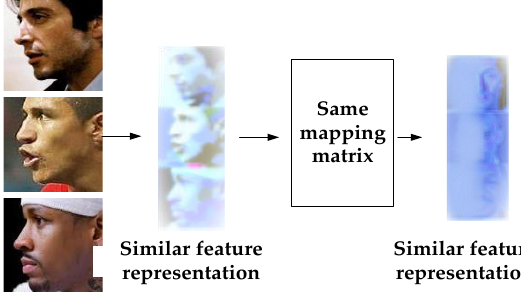
Figure 4. The reason for the small difference between classes.